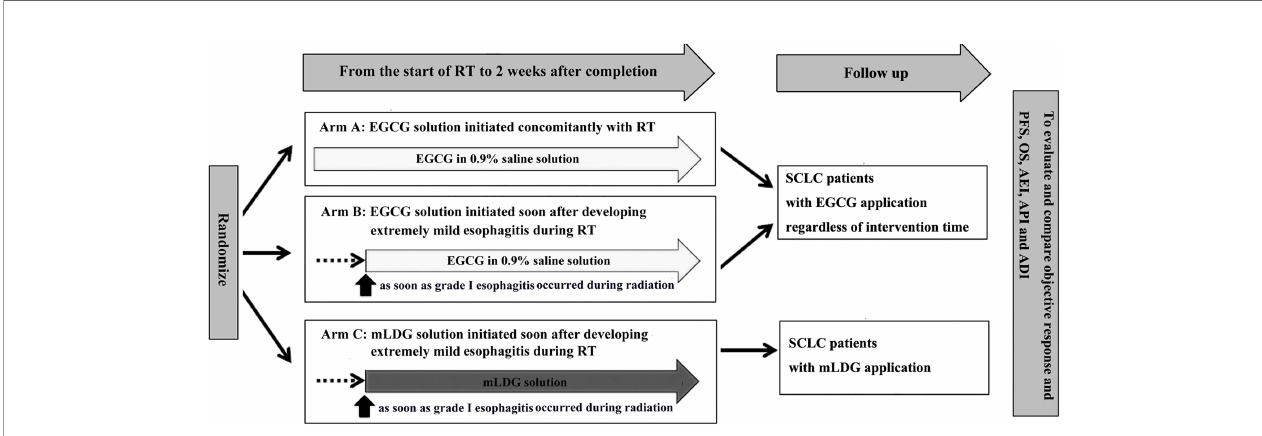
FIGURE 1 | An overview of the study design. EGCG, Epigallocatechin-3-gallate; PFS, progression-free survival; OS, overall survival; AEI, adjusted esophagitis index; API, adjusted pain index; ADI, adjusted